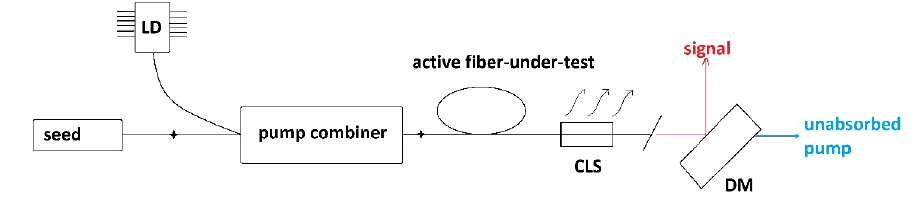
Figure 4. Amplifier